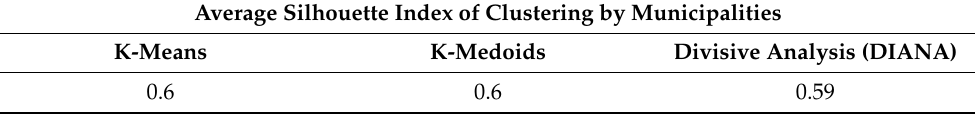
Table 8. Comparison of clustering algorithms for municipal